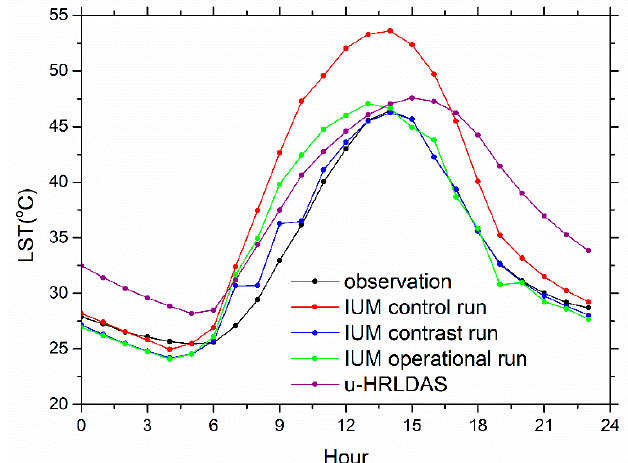
Figure 5. Diurnal cycles of the LST estimate from the IUM from the control run, contrast run, operational run and u-HRLDAS compared with the observation for Yuantong site. Table 2. Biases, mean errors (MEs), root mean square errors (RMSEs) and correlation coefficients (Rs) of the LST estimate from the control run, contrast run, operational run and u-HRLDAS compared with the observation for Yuantong site.